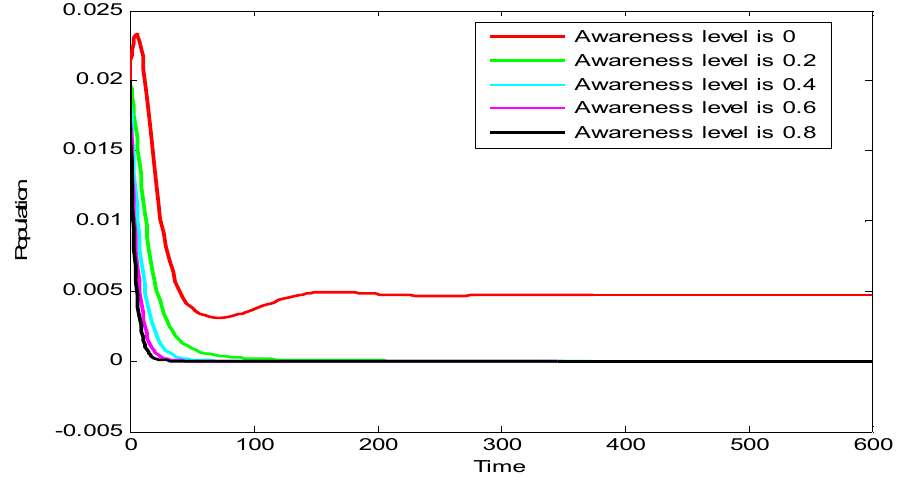
Figure 4. Effect of increasing awareness level.